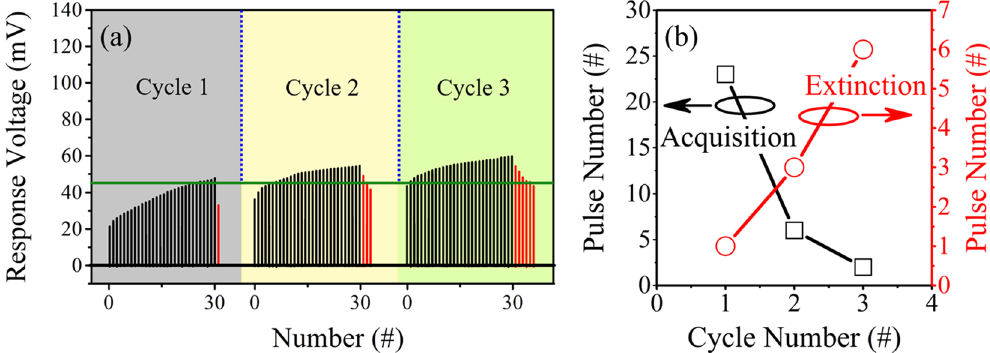
Figure 6. Recovery behavior of the Pavlovian conditioning. ( a ) The three consecutive cycles contain 30 times of training trials and certain times of extinction trials until CR fails, the CS-US temporal relation is 8 ms and the time interval between individual training trials is approximately 0 s. The number of training trials for acquisition decreases, while the number of extinction trials increases in the three consecutive cycles. ( b ) Comparison of the number of training trials for acquisition and the number of extinction trials in each